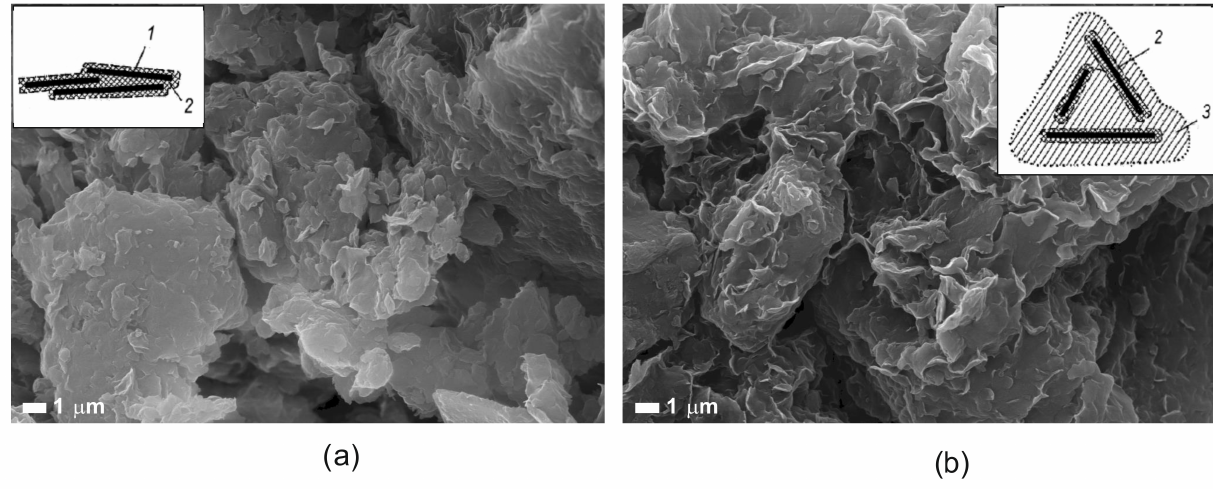
Figure 8. SEM images of the compacted 10X, fraction <0.25 mm, density 1.65 g/cm 3 , at 32,000 × : ( a ) natural micro-aggregates of clay particles after an air-drying; ( b ) partially swelled micro-aggregate of clay particles. Sidebars on the top corners: structural model of clay swelling with different moisture (W) content: ( a ) W ≤ Wmg; ( b ) Wp < W < Wsw (Wmg—maximal hygroscopic moisture content; Wp—moisture of the plastic limit; Wsw—moisture of swelling). 1—clay particle; 2—adsorbed water; 3—osmotic